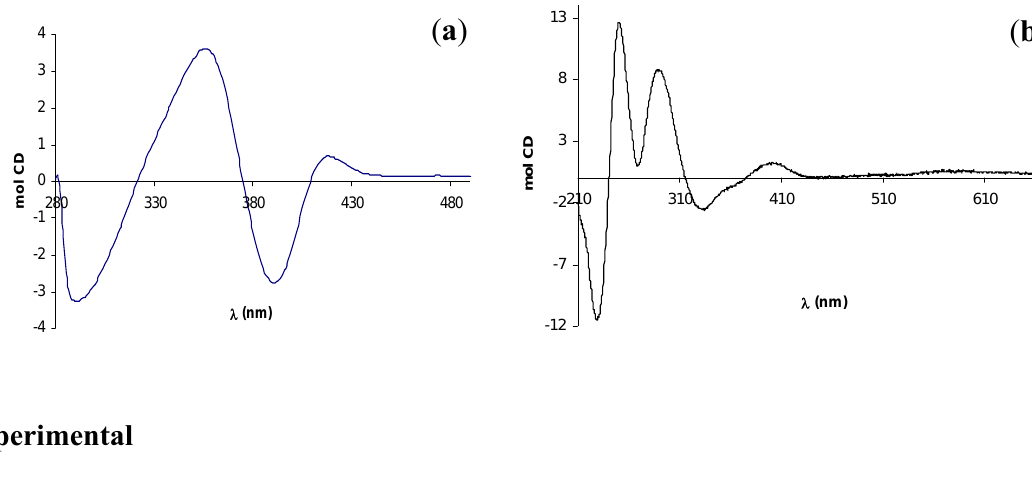
Figure 5. CD spectra of (a) zinc(II) complex (–)- 12 and (b) UO 2 -complex (+)- 13